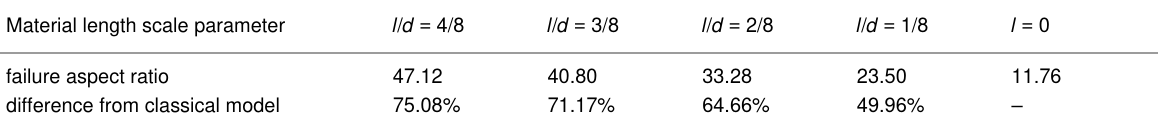
Table 14: Variation of the failure aspect ratio versus l / d for a polystyrene